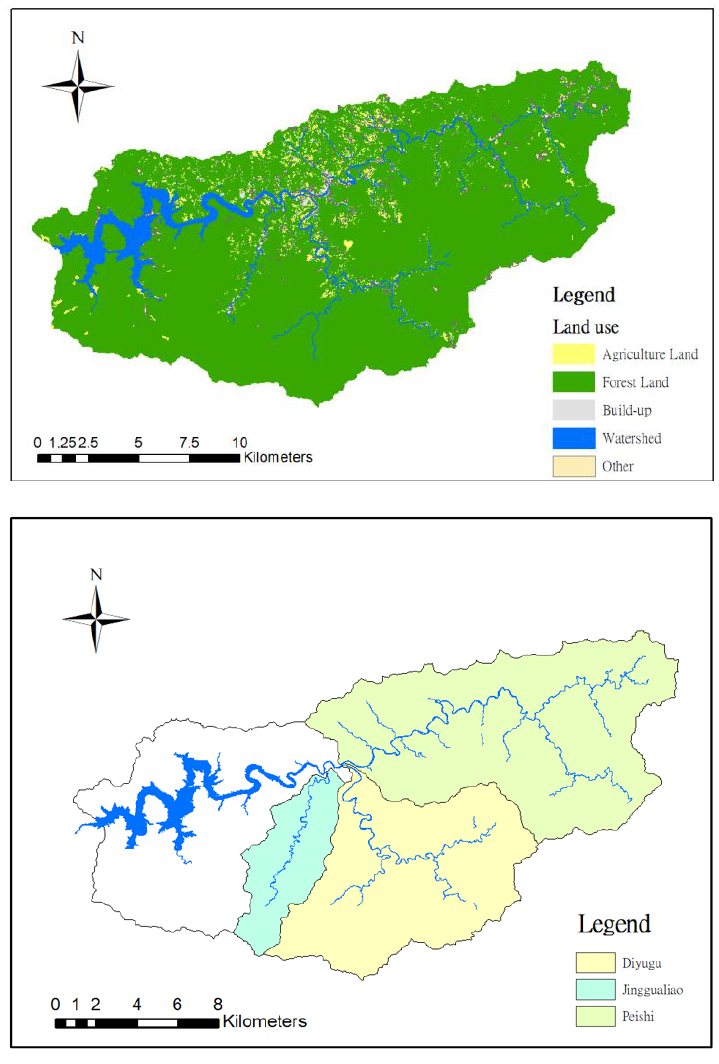
Figure 1. The land use and main streams of the Feitsui Reservoir watershed. The Feitsui Reservoir has very good water quality and from 1987 to 2018, the reservoir reached a eutrophic state only 3% of the time according to official data [25]. In recent years, the trophic level has been mesotrophic to oligotrophic. However, the detailed inflow streams sometimes exceed the required water quality standard in terms of total phospho- rous (TP), especially the Jinggualiao stream. The TP concentration in the Jinggualiao stream from 2015 to 2018 is shown in Figure 2. The TP water quality standard is 20 µ g/L for this reservoir and its streams. While the average TP concentration from 2015 to 2018 was 19.69 µ g/L, which was less than the standard concentration, some of the observations did not meet the